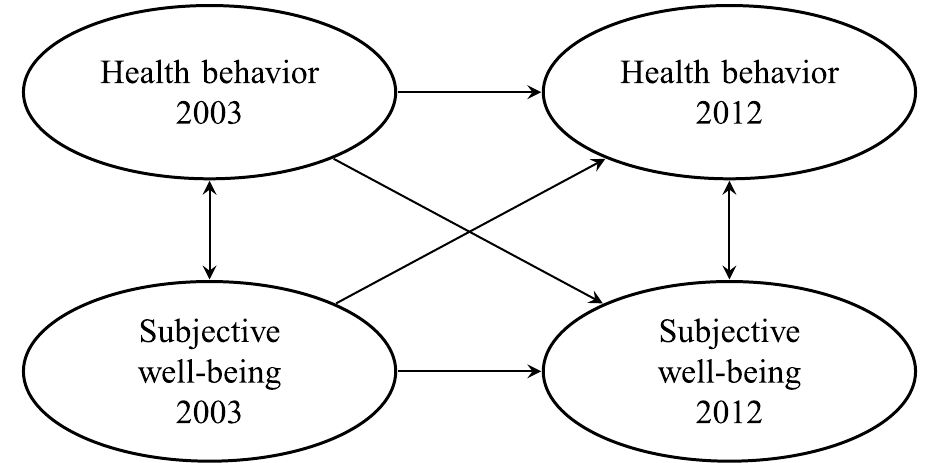
Fig 1. Structural model showing the connections between latent variables that were tested in the